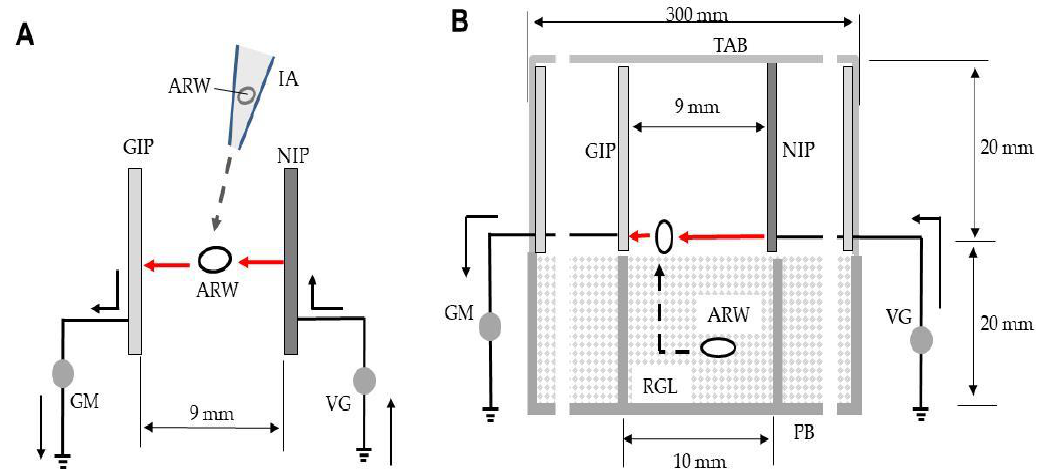
Figure 2. ( A ) Arcing of rice weevils blown into the space between the opposite poles (NIP and GIP) of the ADE. ( B ) Arcing of weevils emerging from rice into the electric field. The solid arrow represents electron movement in the absence of arcing and the red arrow denotes movement during arcing. The dotted arrow is the path taken by the insects. Abbreviations: IA, insect aspirator; ARW, adult rice weevil; GIP, grounded iron plate (conductor); NIP, negatively charged iron plate (conductor); GM, galvanometer; VG, voltage generator; TAB, transparent acrylic box; RGL, rice grain layer; PB, polypropylene box.